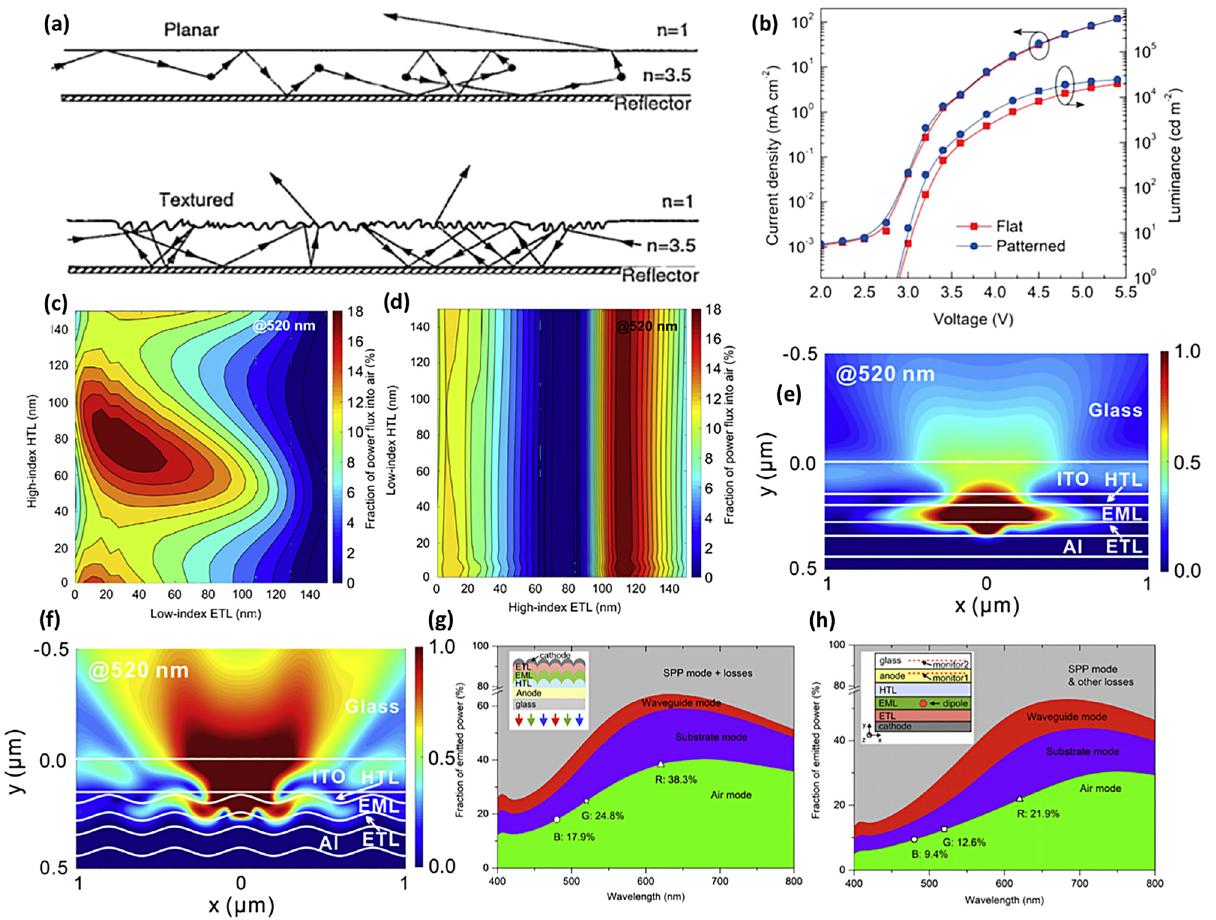
Figure 4: (a) Comparative study of outcoupling efficiency for planar and patterned devices: schematic of light extraction in typical planar and texturedactive layers.Reproducedwith permissionfrom [180].(b) Current density – voltage (J – V) and luminance – voltage (L – V) characteristics for CsPbBr 3 PeLEDs. Reproduced with permission from [70]. Simulated η out of planar PeLEDs emitting at 520 nm vs. the layer thickness of ETL andHTLwith(c)low-indexETLandhigh-indexHTLand(d)high-indexETLandlow-indexHTL,high-indexandlow-indexrefertothevaluesof2.5 and 1.5 respectively. Normalized cross-section near- fi eld intensity distributions of PeLEDs without and with the moth-eye nanopatterns for light extraction in (e) planar and (f) patterned device structures emitting at 620 nm. Fractions of mode powers of (g) planar and (h) patterned PeLEDs with an isotropic dipole orientation as a function of dipole-emitting wavelength calculated by the FDTD method. The theoretical maximums of red (620 nm, circle), green (520 nm, star) and blue (480 nm, triangle) emitted powers into air are marked. Reproduced with permission from